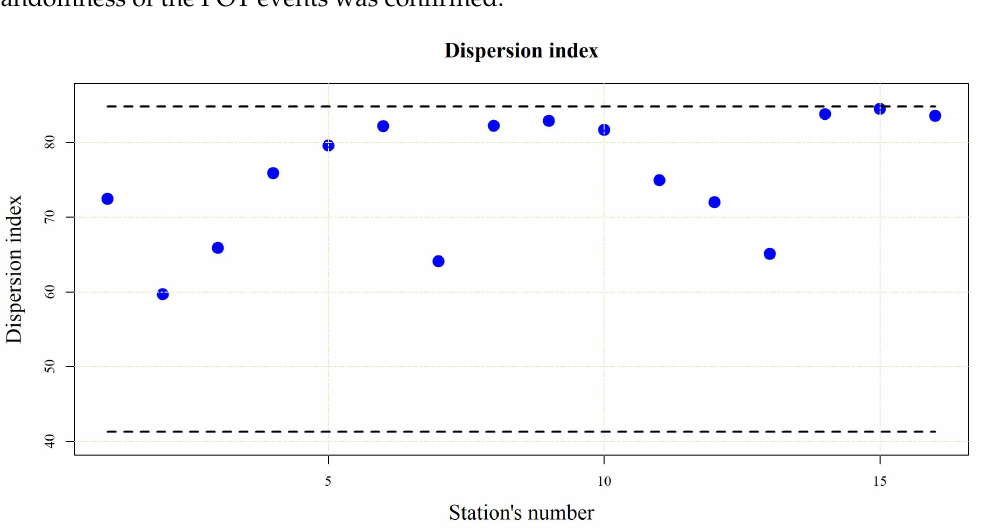
Figure 3. Values of the dispersion index ψ and limits of the confidence interval.